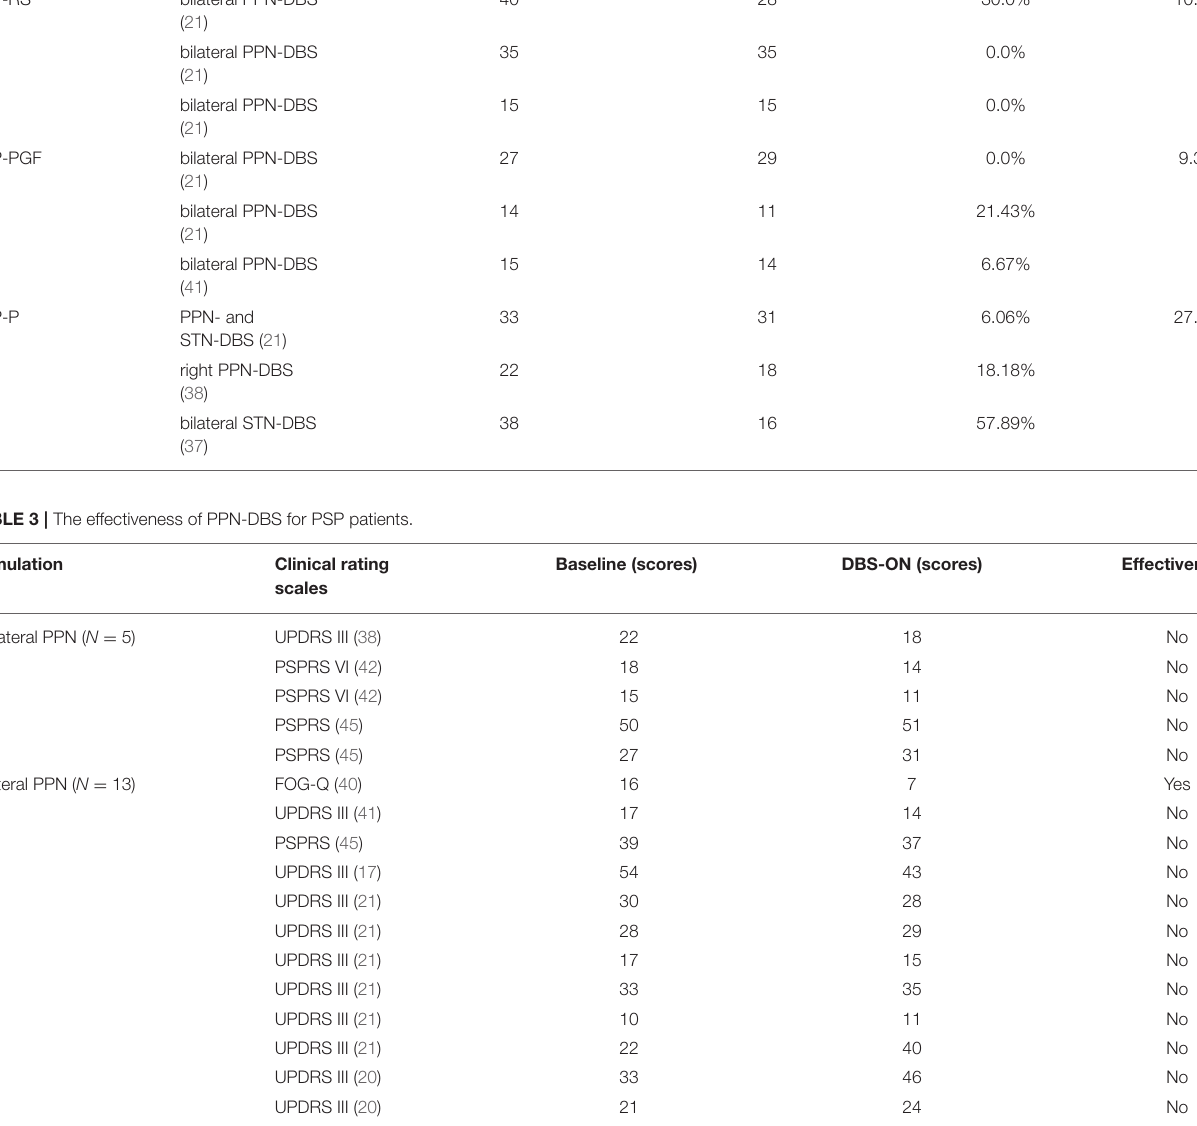
TABLE 2 | UPDRS III scores of patients with different PSP phenotypes.